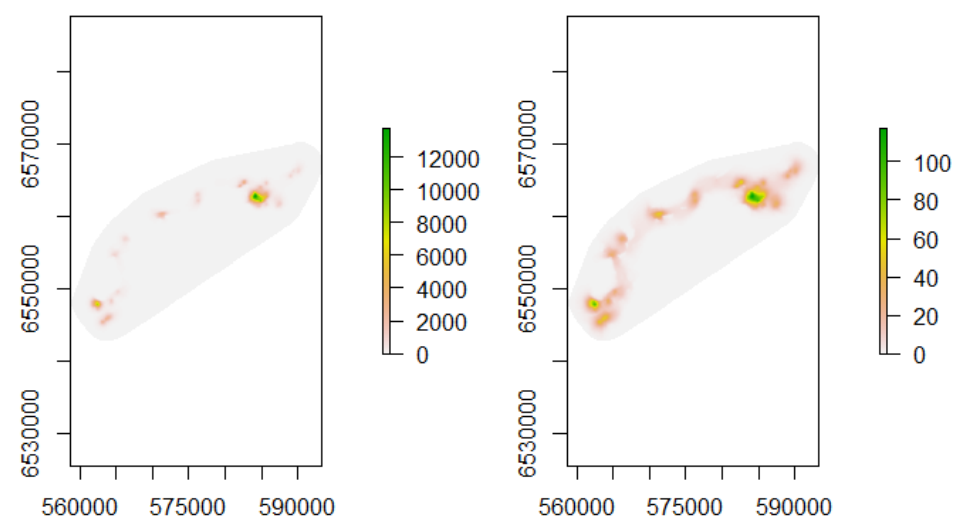
Figure 16: Output UD and square root of